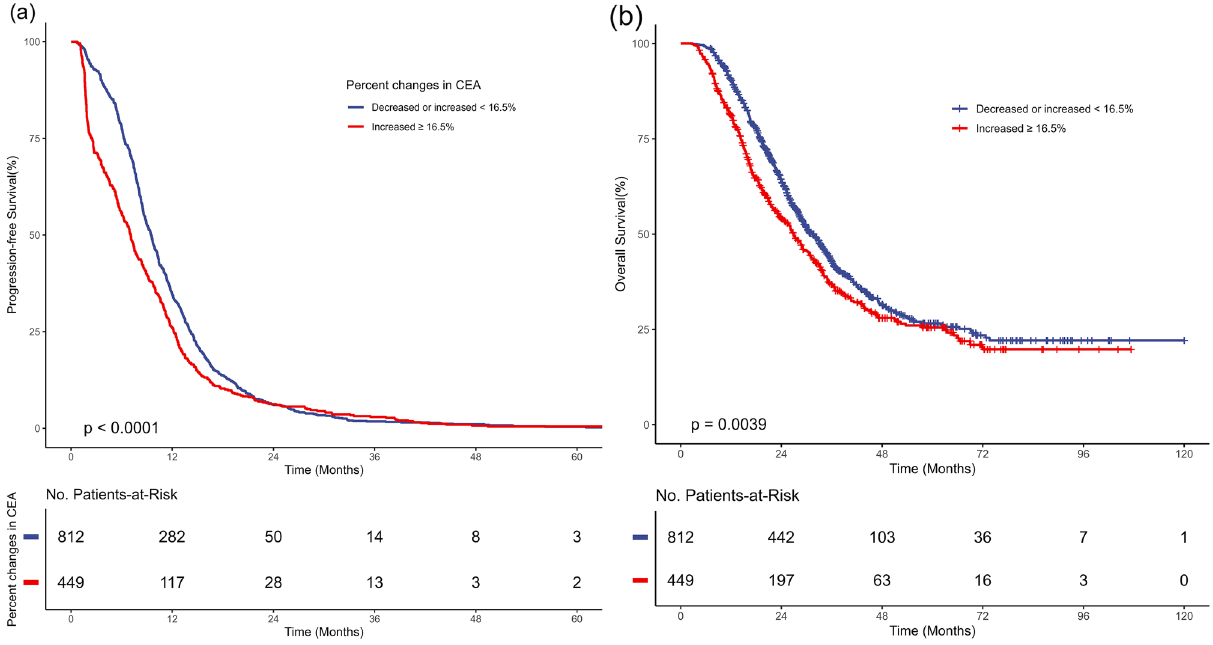
Figure 4. ( a ) Progression-free survival (PFS) and ( b ) overall survival (OS) according to the serum carcinoembryonic antigen (CEA) cut-off value for the whole cohort.